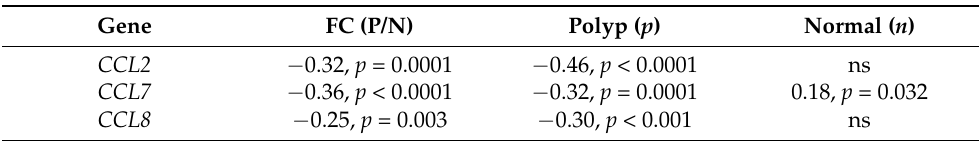
Table 4. Effect of cumulative risk of adenoma-to-adenocarcinoma transformation on expression of MCP